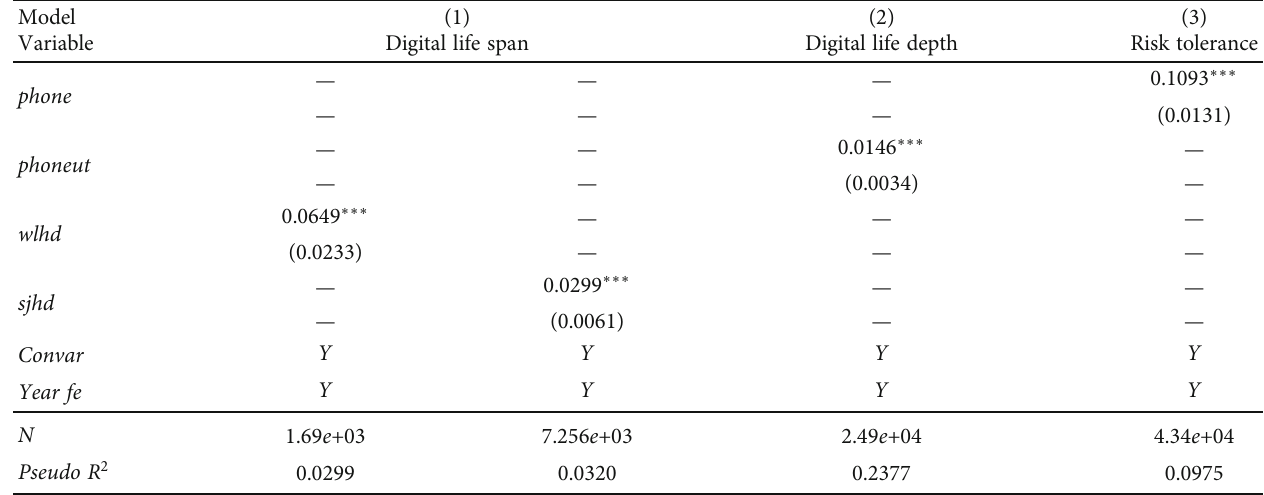
Table 10: Results of further